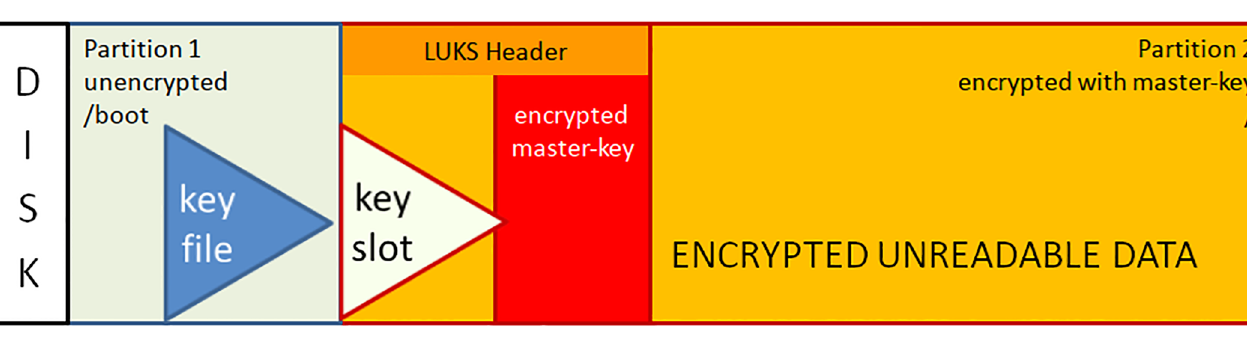
Fig 1. Initial layout of the LUKS encrypted disk.